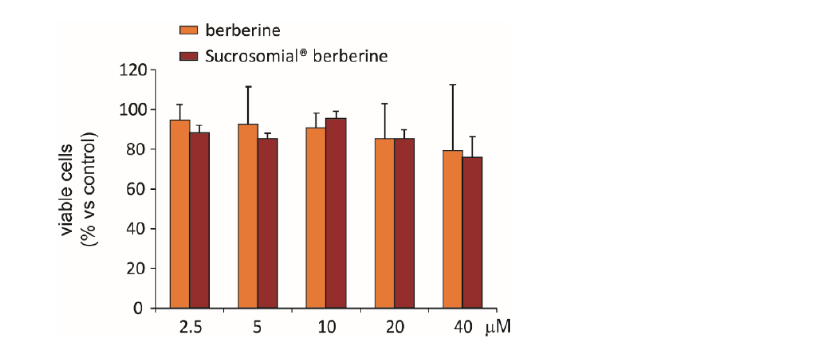
Figure 1. Cytotoxic effect of berberine and Sucrosomial ® berberine on Huh7 cell line. Huh7 cells were incubated for 24 h with indicated concentrations of berberine and Sucrosomial ® berberine. Cell viability was then determined by SRB assay.